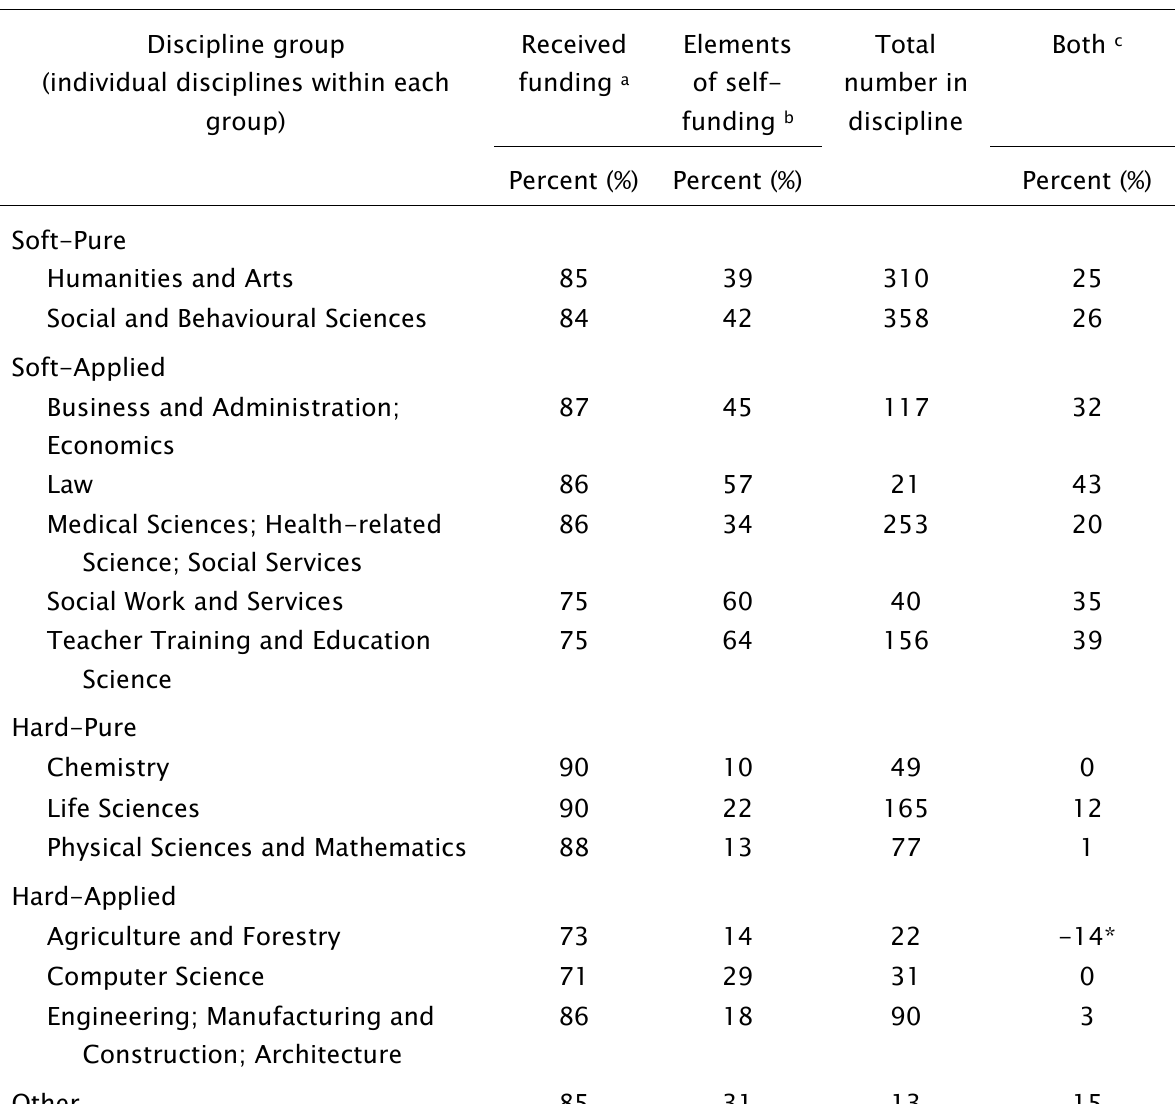
Respondents Who Indicated Receiving Funding, Self-Funded, or